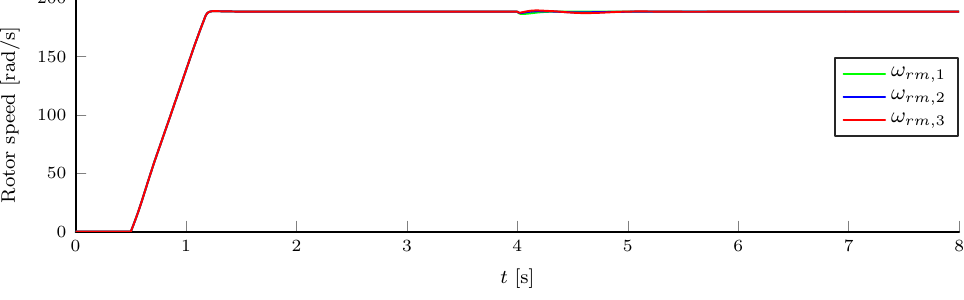
Figure 20. Mechanical rotor velocities including start-up; current-source